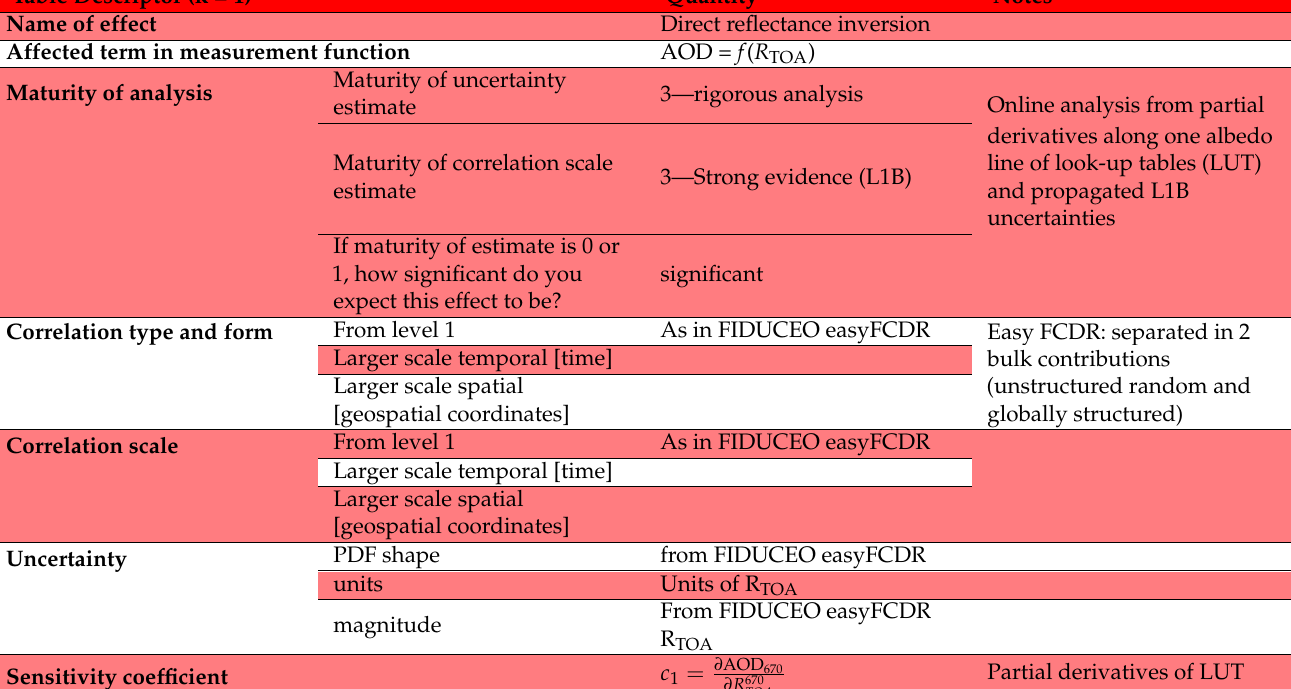
Table 1. Effects table for direct reflectance